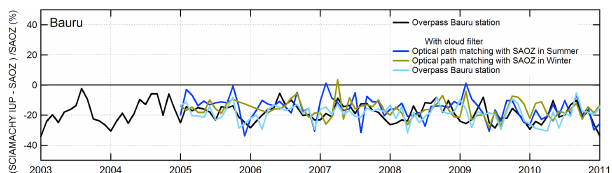
Figure A2. Same as Fig. A1 after removing days with cloud cover > 30%. Except during convective summer, cloud filtering has little impact on NO 2 monthly mean